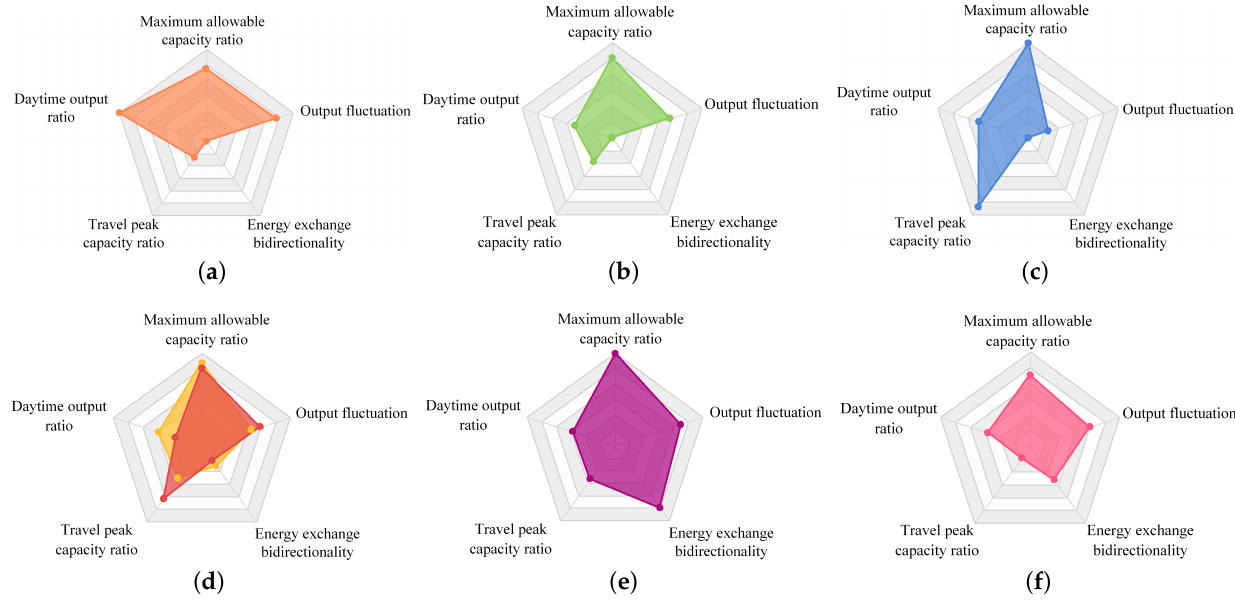
Figure 1. Radar charts of the typical output characteristics of the six classes of distributed